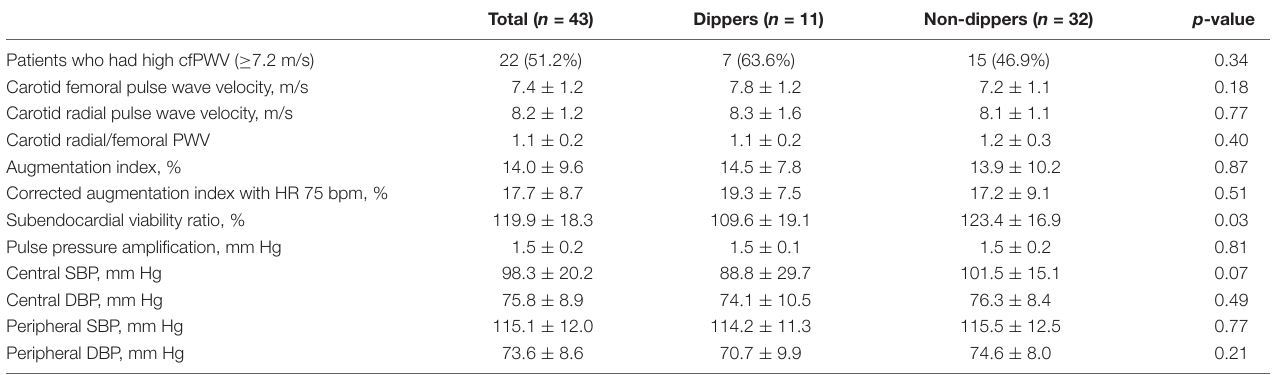
TABLE 6 | Arterial stiffness characteristics of participants stratified by blood pressure dipping status. Total ( n = 43) Dippers ( n = 11)